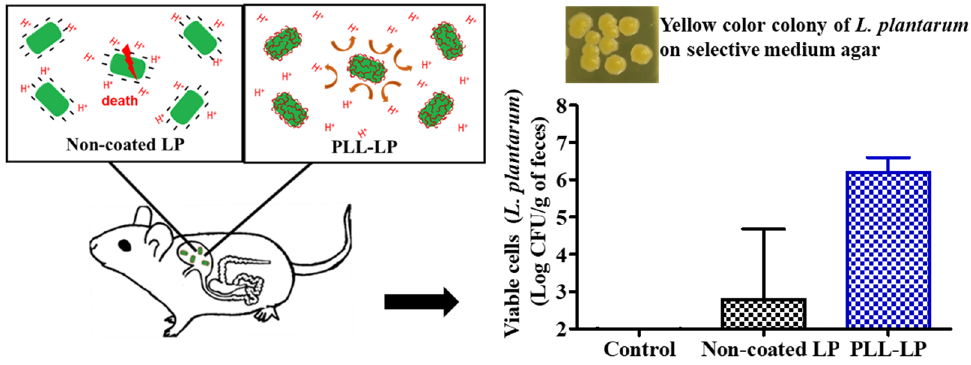
Figure 6. Survival of L . plantarum after 24 h observed in the feces of ICR mice administered non-coated LP or PLL-LP by oral gavage. The control group comprised ICR mice administered distilled water by oral gavage. The error bar represents the standard deviation ( n = 4).